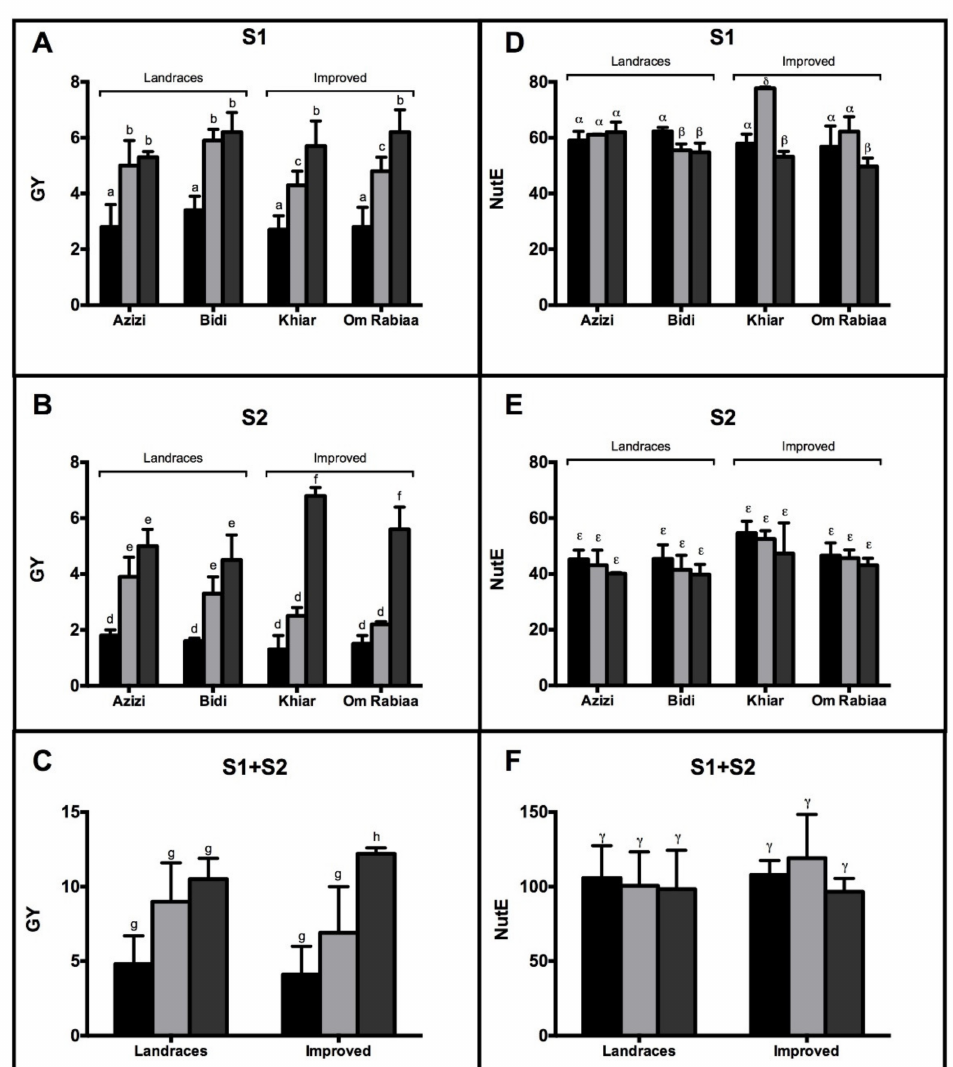
Figure 2. Variation in grain yield (GY) and of NutE for different genotypes ( A , B , D , E ) and for each genotypic pool (landraces and improved ( C , F )) at different nitrogen rates 0 (black bars), 75 (light grey bars), 150 (dark grey bars) kg N ha − 1 . S1 and S2 correspond to 2010 and 2011, respectively. Each value is the mean SD for each genotype and nitrogen supply ( n = 3 for genotypes and n = 3 for N supplies). Letters indicate significant differences between treatments for different